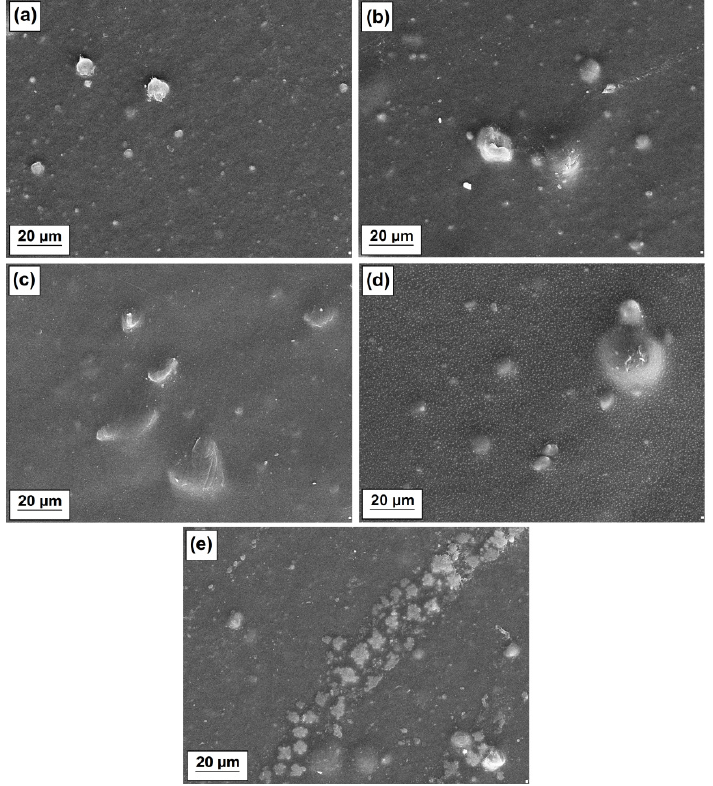
Figure 4. SEM images of obtained composites: LDPE/MgO ( a ), LDPE/MgO-L (5:1 wt./wt.) ( b ), LDPE/MgO-L (1:1 wt./wt.) ( c ), LDPE/MgO-L (1:5 wt./wt.) ( d ) and LDPE/lignin ( e ).